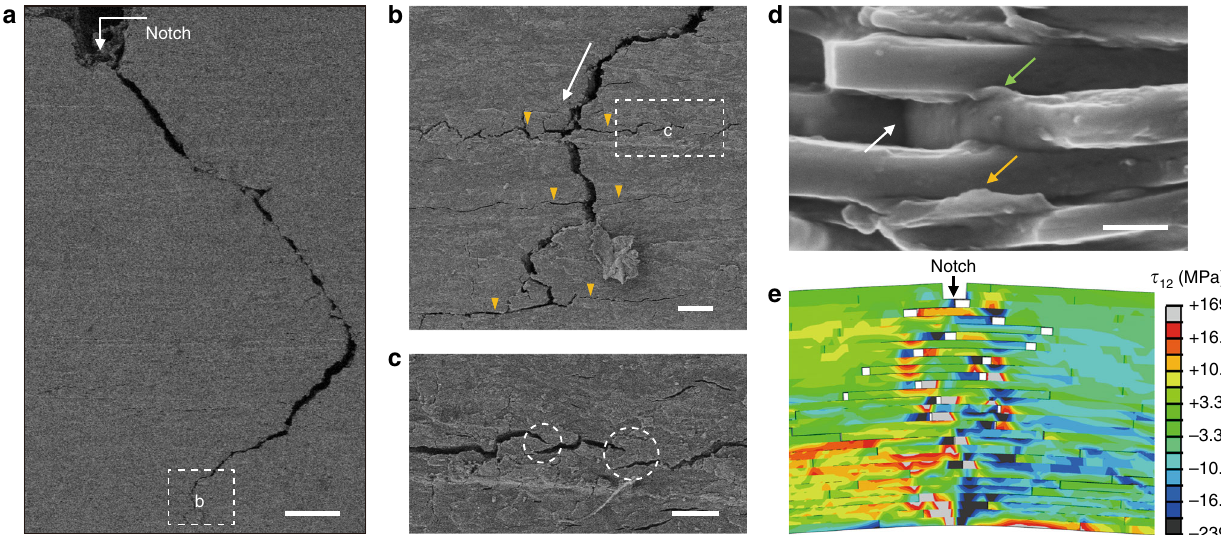
Fig. 3 Multiple extrinsic toughening mechanisms acting at multiple length scales. a Long-range crack de fl ection. White arrow indicates the initial crack near the notch. Scale bar , 200 μ m. b Crack de fl ection, branching, and multiple cracking. White arrow indicates the extension direction of the main crack. Yellow arrows indicate the onset of crack branching. Scale bar , 20 μ m. c Crack bridging toward the end of a crack path. Scale bar , 10 μ m. d Details of the fracture surfaces showing polymer bridging, stretching, and platelets ’ pulling out. White arrow indicates the cavity resulted from platelet pull-out. Green arrow shows the polymer bridging between adjacent platelets. Yellow arrow displays that the polymer stretching resulted from interface failure. Scale bar , 400nm. e Microcrack de fl ection and crack bridging near the crack tip by progressive interface failure via nonlinear fi nite element model (FEM) simulation. τ 12 means the shear